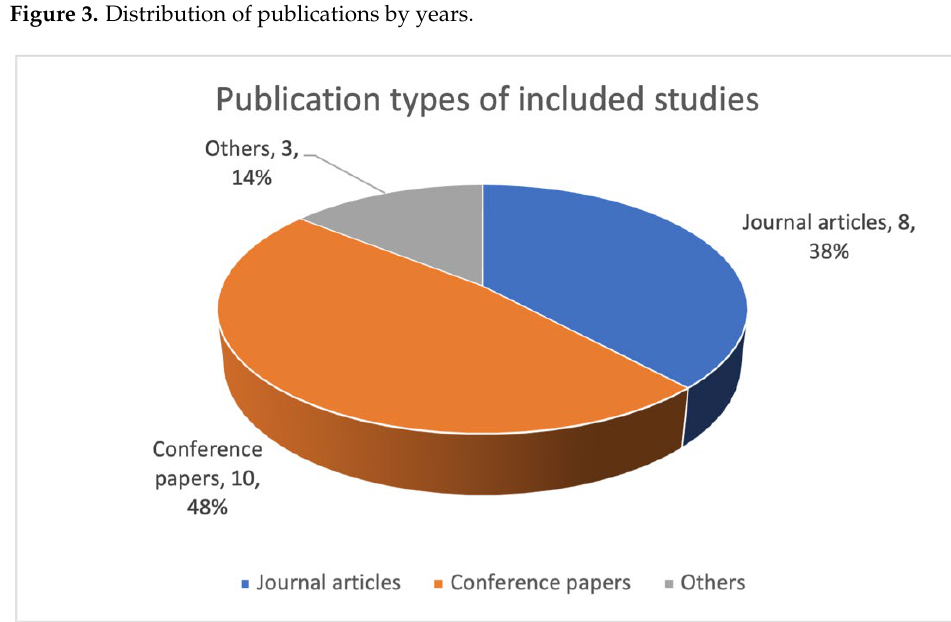
Figure 4. Distribution of included studies by publication types.